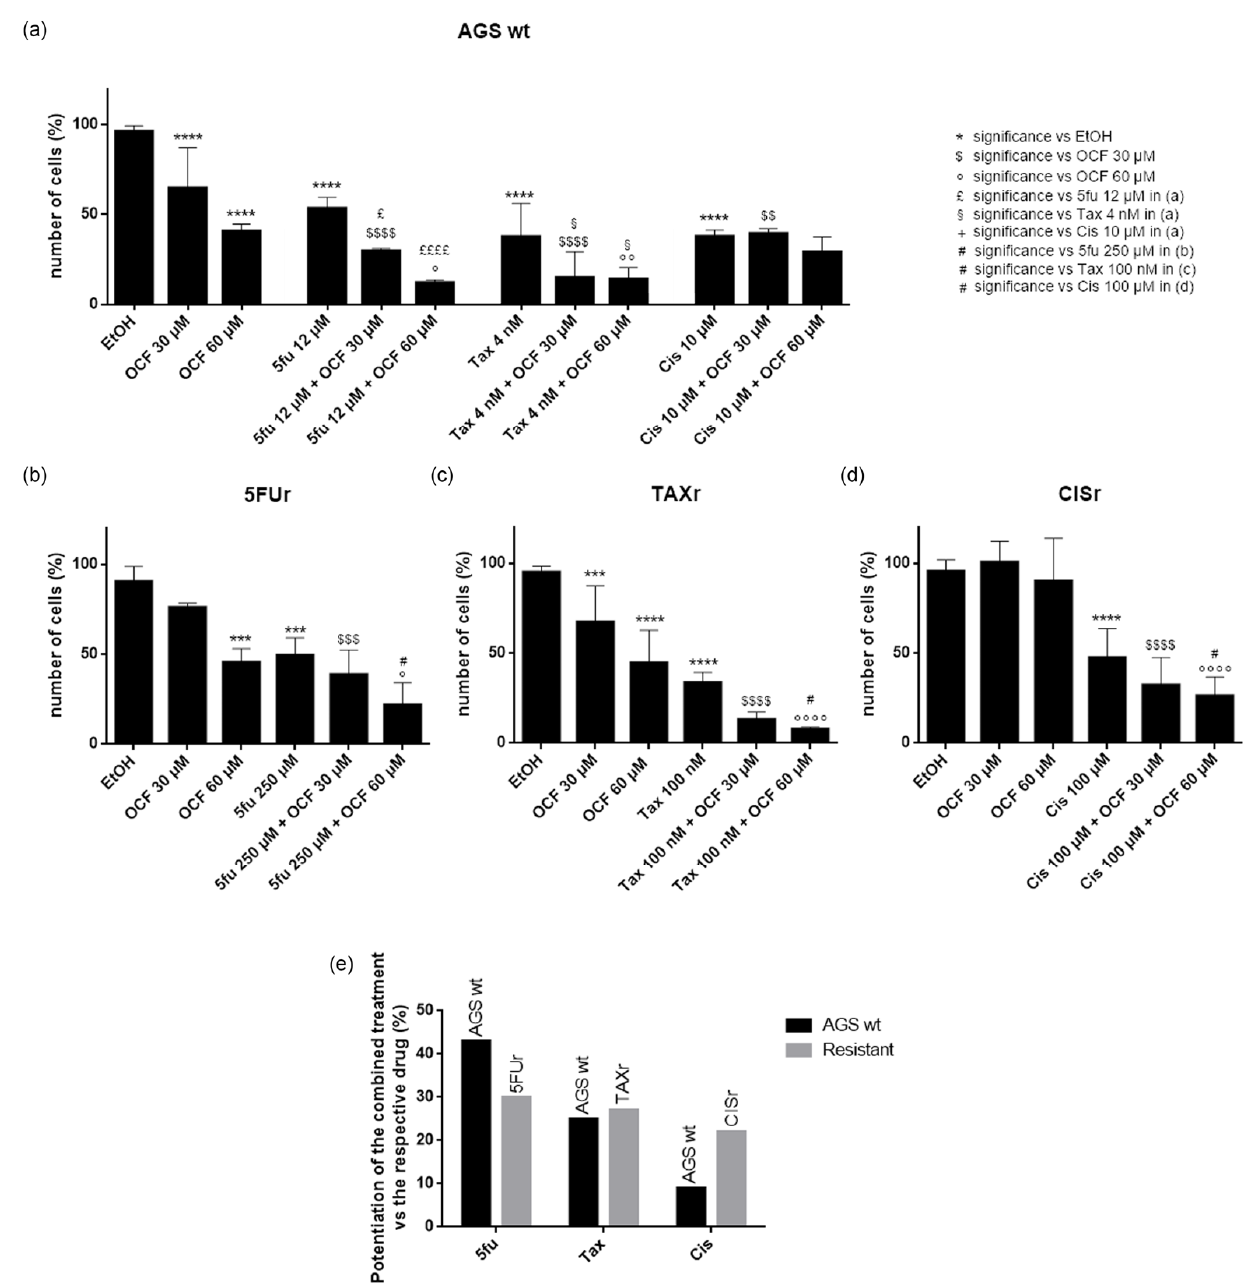
Figure 11. Effects of chemotherapeutic drugs in combination with the OCF on AGS wt and resistant cells. Cell count after 72 h treatment. AGS wt cells were treated with vehicle/OCF 30 µM/OCF 60 µM ± IC 50 dose of 5-fluorouracil (12 µM)/Paclitaxel (4 nM)/cisplatin (10 µM) ( a ). 5FUr cells were treated with vehicle/OCF 30 µM/OCF 60 µM ± IC 50 dose of 5-fluorouracil (250 µM) ( b ). TAXr cells were treated with vehicle/OCF 30 µM/OCF 60 µM ± IC 50 dose of Paclitaxel (100 nM) ( c ). CISr cells were treated with vehicle/OCF 30 µM/OCF 60 µM ± IC 50 dose of cisplatin (100 µM) ( d ). Representation of the percentage increase in efficacy between combined treatments (IC 50 dose of drug and 60 µM OCF) vs the mono-treatment with the single IC 50 dose of the drug in the different cell lines obtained from the previous experiments is shown in this figure ( e ). Data are presented as mean ± SD of three independent experiments. Meaning of the following significance symbols is specified on top-right of the figure: *** p < 0.001, **** p < 0.0001, $ p < 0.05, $$ p < 0.01, $$$ p < 0.001, $$$$ p < 0.0001, ◦ p < 0.05, ◦◦ p < 0.01, ◦◦◦◦ p < 0.0001, £ p < 0.05, ££££ p < 0.0001, § p < 0.05, # p < 0.05 (Two-way ANOVA Tukey’s multiple comparisons